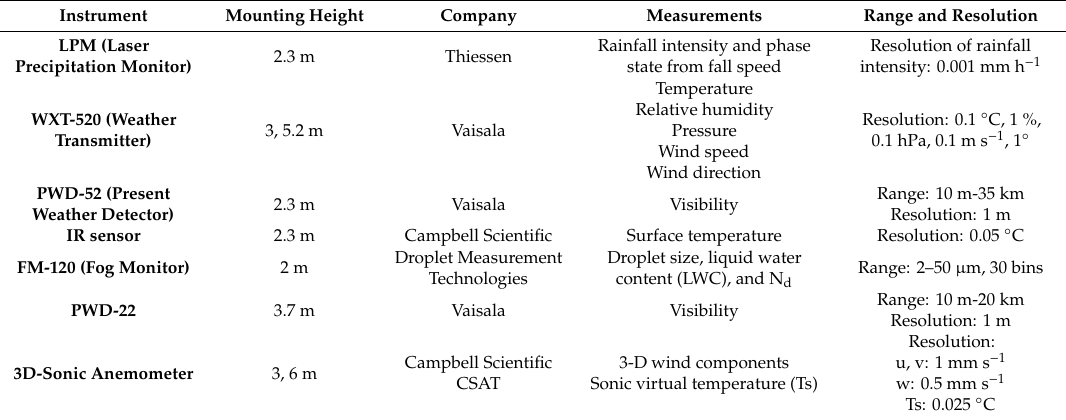
Table 1. The list of surface instruments used during the ICE-POP campaign.